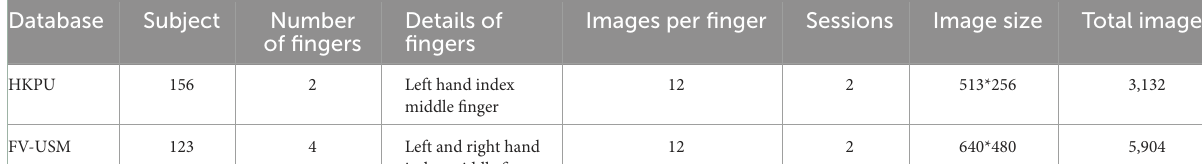
TABLE 4 Finger-vein databases.